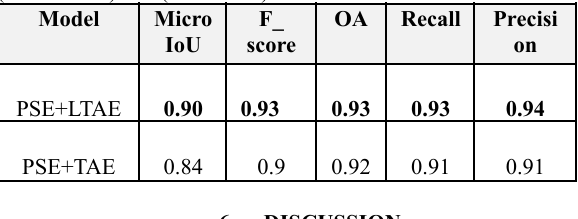
Table 7. Results of transfer learning using pre-trained models (PSE+LTAE) and (PSE+TAE) Model Micro F_ OA Recall Precisi IoU score PSE+LTAE 0.90 0.93 0.93 0.93 0.94